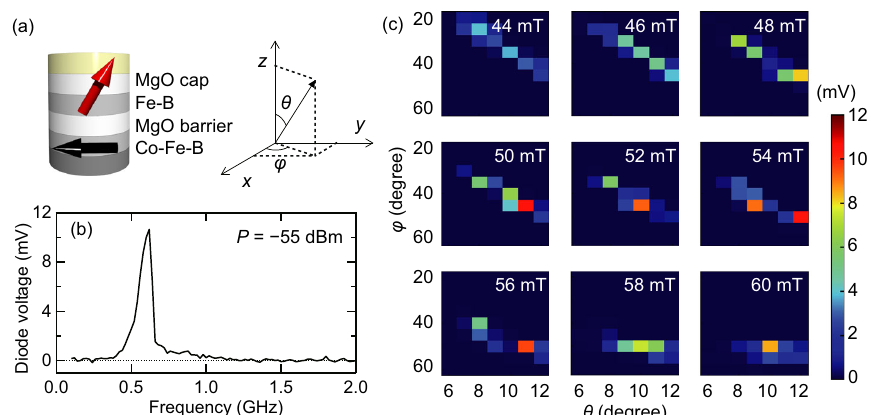
Fig. 2 Spin-torque diode spectrum. a Schematic of a magnetic tunnel junction and a coordinate system with azimuthal angle θ and rotation angle φ . The red and black arrows represent the free and pinned layer magnetizations, respectively. b Frequency dependence of diode voltage under magnetic fi eld B = 50 mT, θ = 11°, and φ = 45° at a dc bias current I dc = − 2.6 mA. Input microwave power P is − 55 dBm. c Color mapping of diode voltages under magnetic fi eld intensities of 44 – 60 mT, azimuthal angles of 6° – 12°, and rotation angles of 20° – 60°.